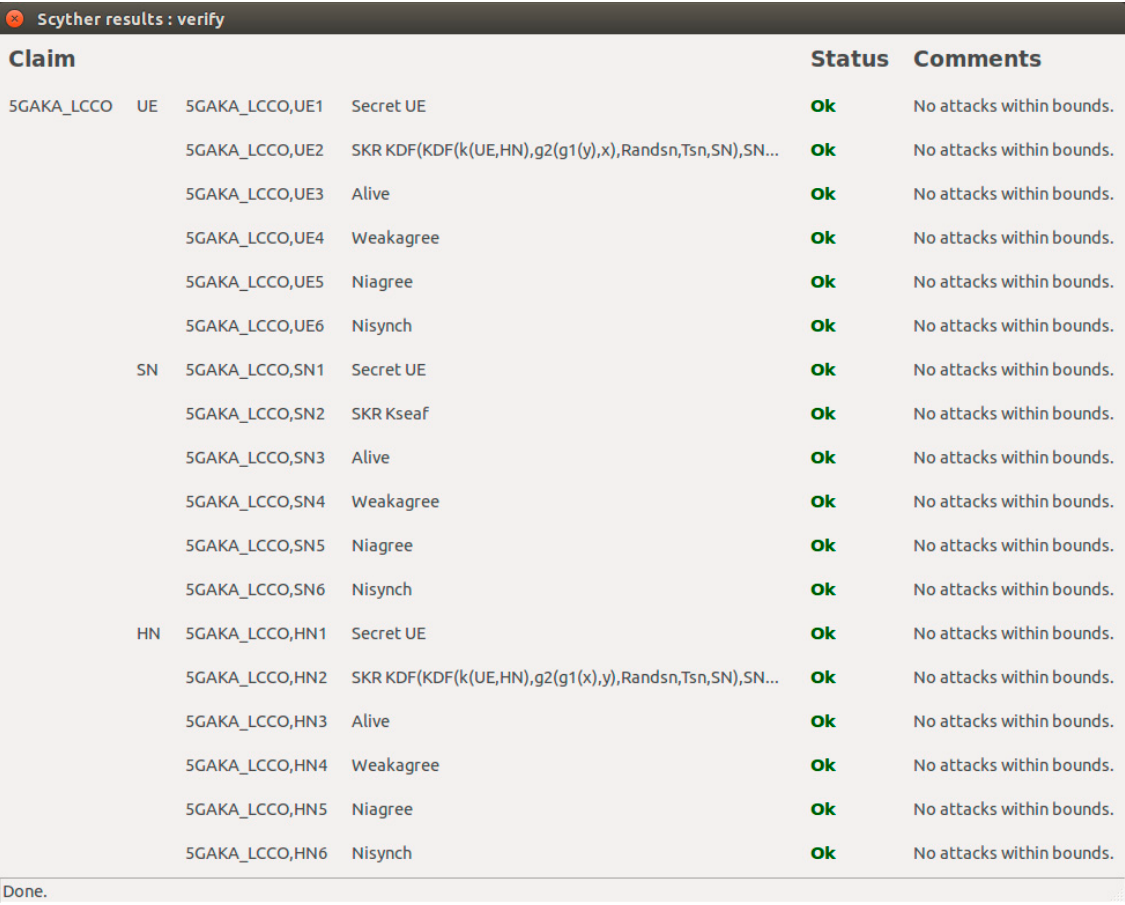
Figure 6. Security simulation results of the 5GAKA-LCCO protocol in the Scyther tool.